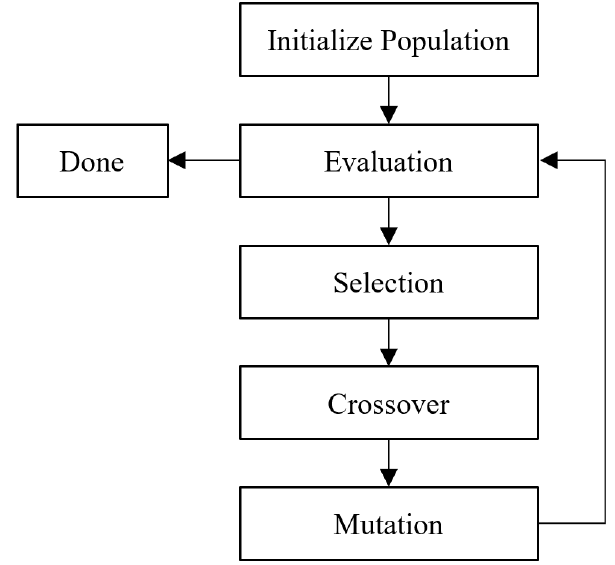
Figure 8. Genetic algorithm flowchart.